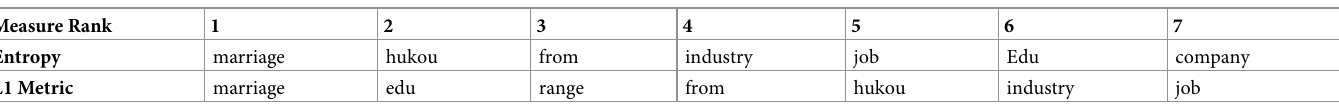
Table 1. High scoring features.